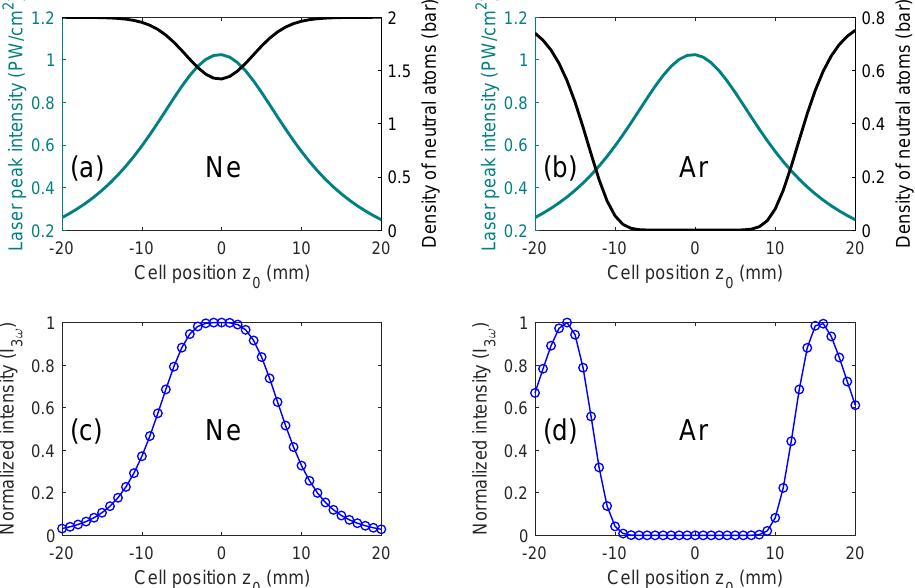
Figure 4. Atomic neutral densities and THG yields. ( a , b ) show the variation of neutral-atomic densities and laser intensity for different cell positions. ( c , d ) are estimated THG yields, indicating that the maximum DUV yield is expected when the cell is placed off the laser focus in the case of Ar. For Ne ( a ), 25% of the neutral atoms are expected to be ionized when the cell is positioned at the laser focus. For Ar ( b ), the neutral atoms are totally depleted near the focus. Asymmetry in the DUV yield (dashed lines in Figure 3a,b) with respect to the gas